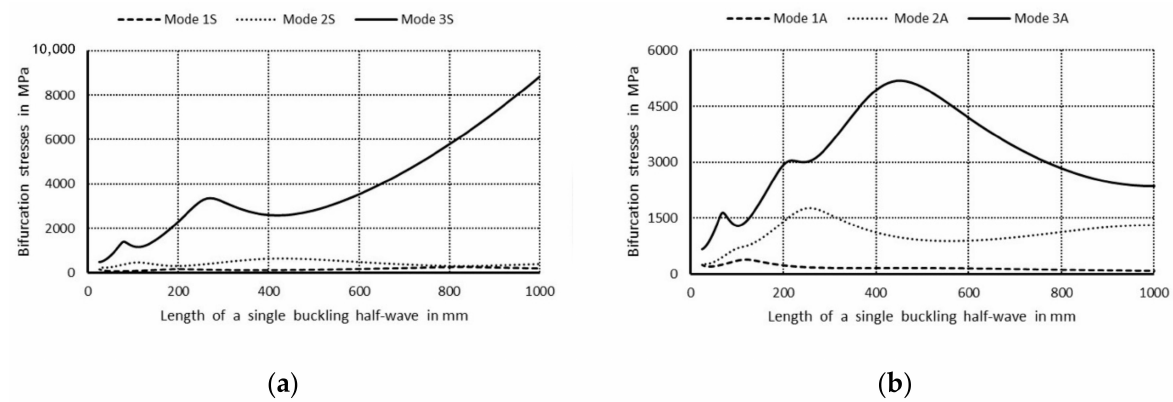
Figure 11. Values of bifurcational stress in MPa as a function of the length of one buckling half-wave in mm: ( a ) first three symmetrical buckling modes, ( b ) first three anti-symmetrical buckling